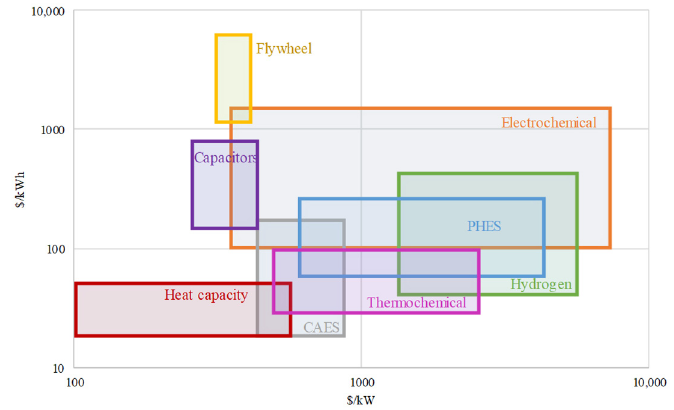
Figure 10. Cost of energy accumulation systems.